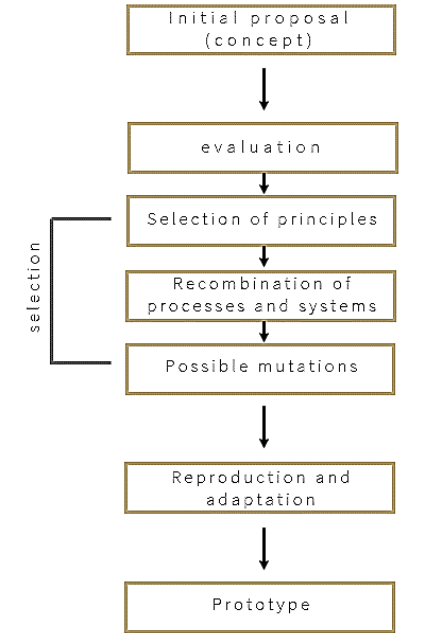
Figure 4. Ways in which the shape can regenerate, grow and / or adapt to the environment in which it is placed. Each of these systems, explaining the nature and type of their metamorphosis, is analysed and the underlying